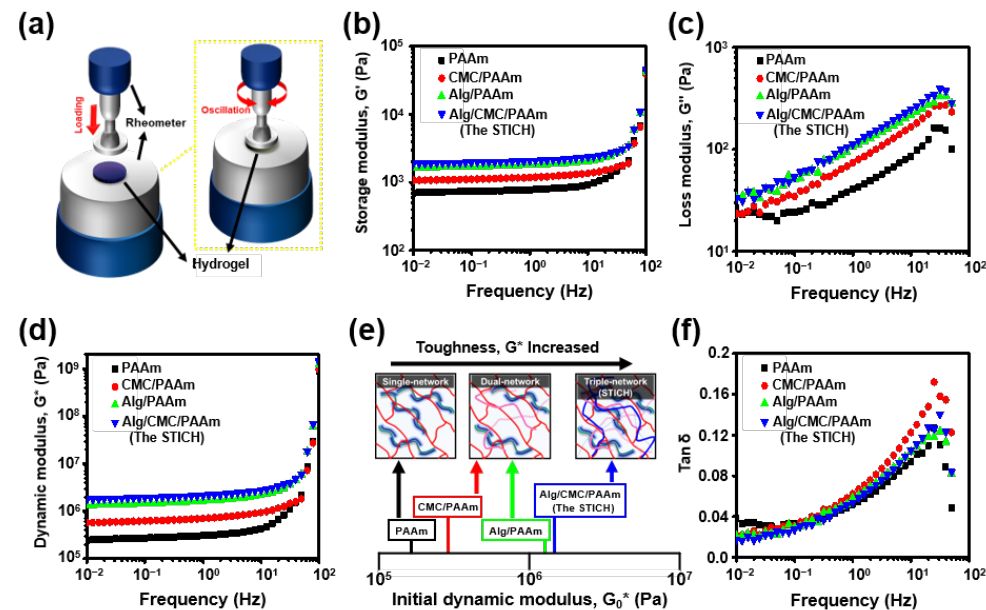
Figure 4. Rheological characterization of the Alg, CMC, and PAAm-based conductive hydrogels. ( a ) The experimental setting illustration of the rheological property measurements of the Alg, CMC, and PAAm-based conductive hydrogels ( n = 3). ( b ) Storage modulus ( G ’) of each Alg, CMC, and PAAm-based conductive hydrogel. ( c ) Loss modulus ( G ”) of each Alg, CMC, and PAAm-based conductive hydrogel. ( d ) Dynamic modulus ( G *) of each Alg, CMC, and PAAm-based conductive hydrogel. ( e ) Initial dynamic modulus on a log scale for “PAAm” (single-network), “CMC/PAAm” and “Alg/PAAm” (dual-network), and STICH (triple-network). ( f ) Tan δ of each Alg, CMC, and PAAm-based conductive hydrogel. (“PAAm”, black; “Alg/PAAm”, green; “CMC/PAAm”, red; and “ Alg/CMC/PAAm ” , the STICH, blue).